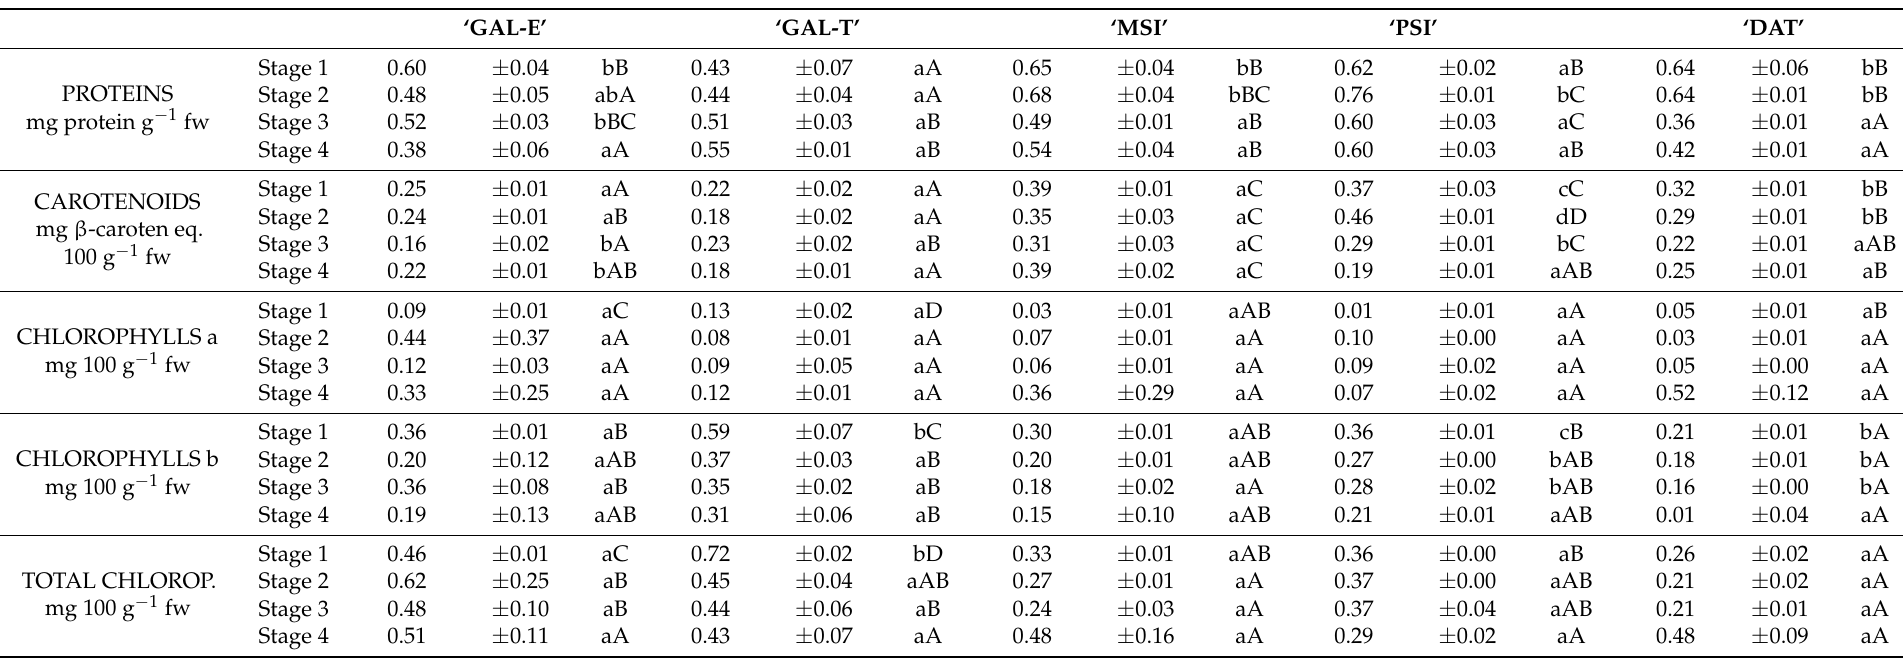
Table 2. Photosynthetic pigments (mg 100 g − 1 fw) of jujube fruits as affected by cultivar and stage of